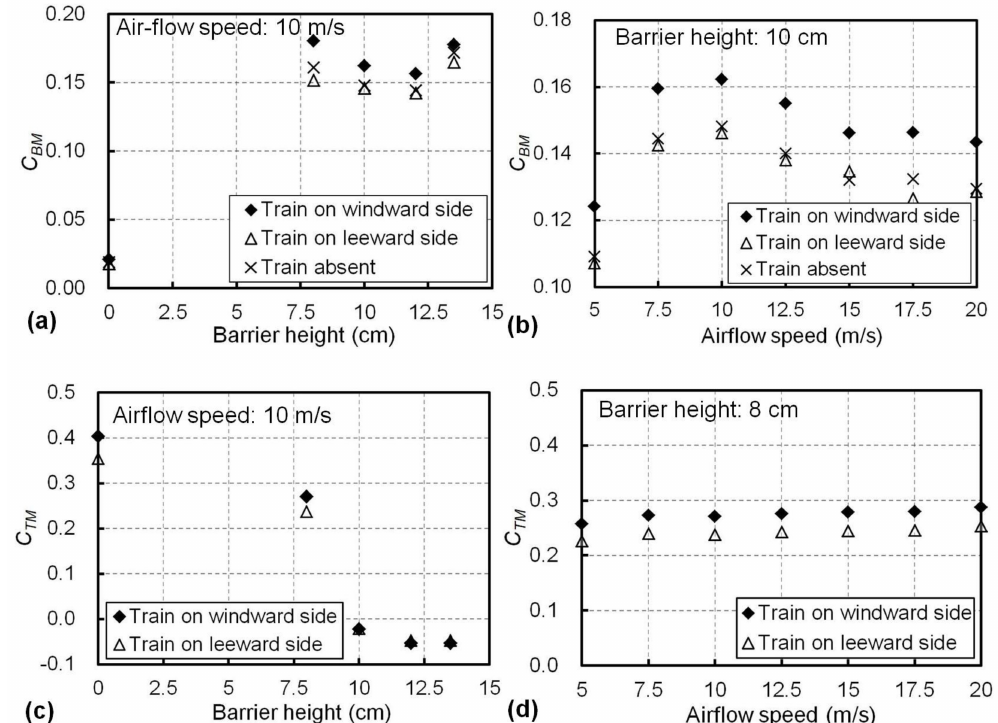
Figure 7. Overturning-moment coe ffi cient responses for di ff erent train locations for ( a ) the bridge at an airflow speed of 10 m / s and di ff erent barrier heights, ( b ) the bridge with a barrier height of 10 cm and di ff erent airflow speeds, ( c ) the train at an airflow speed of 10 m / s and di ff erent barrier heights, and ( d ) the train with a barrier height of 8 cm and di ff erent airflow